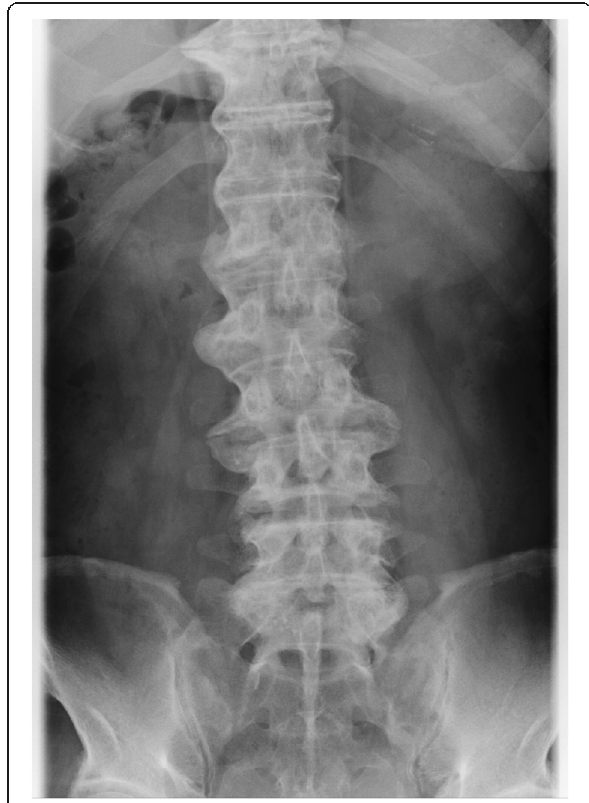
Fig. 1 Plain radiographs of the lumbar spine. Antero-posterior view shows non-specific, mild to moderate degenerative changes